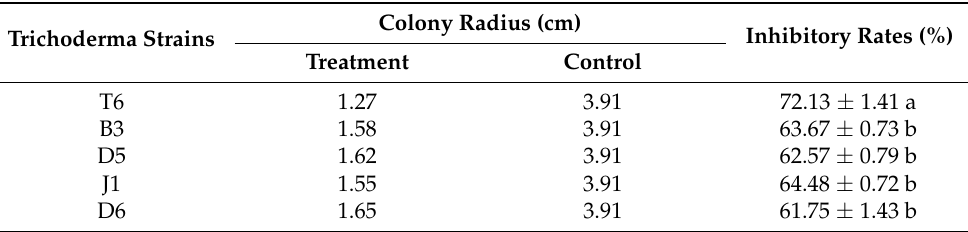
Table 1. Inhibitory activity of Trichoderma strains on the growth of the peach brown rot pathogen of the Monilia yunnanensis T8-1 isolate.